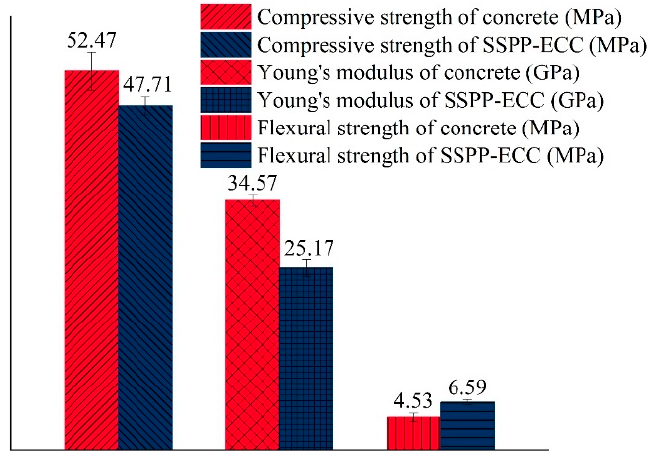
Figure 7. Results of the basic mechanical properties test.